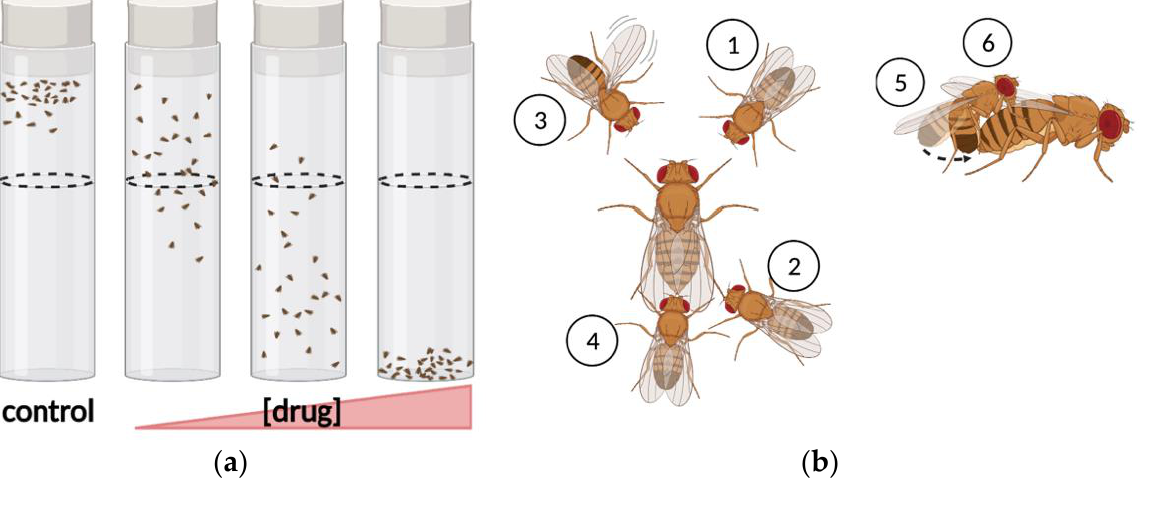
Figure 3. Assays for measuring motor-impairing effects of psychostimulants in Drosophila ( a ) Representation of climbing behavior in the negative geotaxis assay. Untreated flies are located at the top of the tube, while psychostimulant exposure disrupts climbing behavior in a dose dependent manner. ( b ) Depiction of the courtship stages quantified in the courtship behavior assay. Numbers represent successive steps in the courtship process, where 1–4 (left) depict a single male fly performing four sequential courtship displays: (1) orientation (2) tapping (3) wing-song (4) licking. Step (5) and (6) portray copulation attempts (mounting behavior) along with successful copulation, respectively. Recorded video data are used to quantify the number and duration of courtship behaviors. Created with BioRender.com.